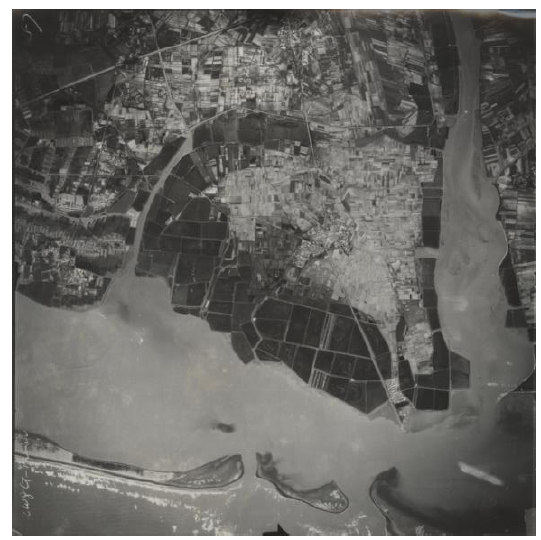
Figure 2. Example of edited